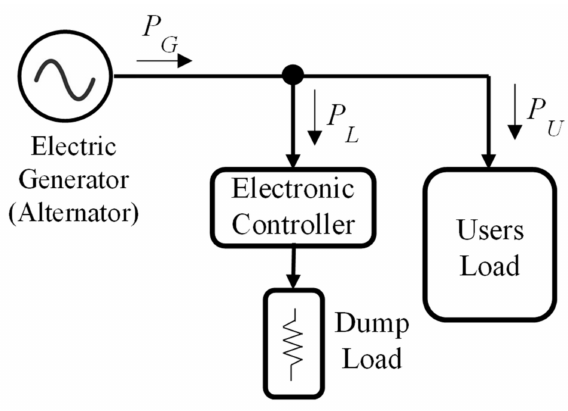
Figure 1. Electronic load controller (ELC) for frequency